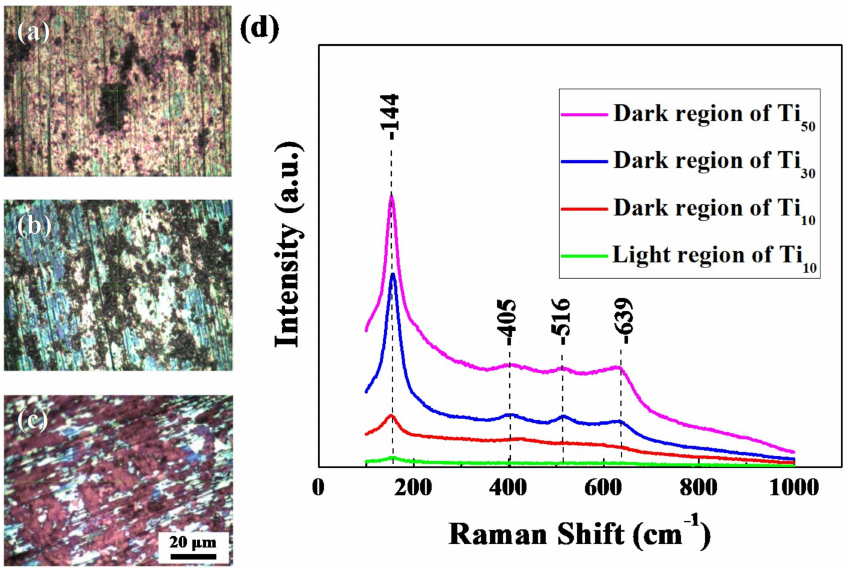
Figure 3. Optical microscopy pictures of passive film formed on different potentials ( a ) Ti 10 , ( b ) Ti 30 , ( c ) Ti 50 , ( d ) Raman spectrum of passive film formed on different